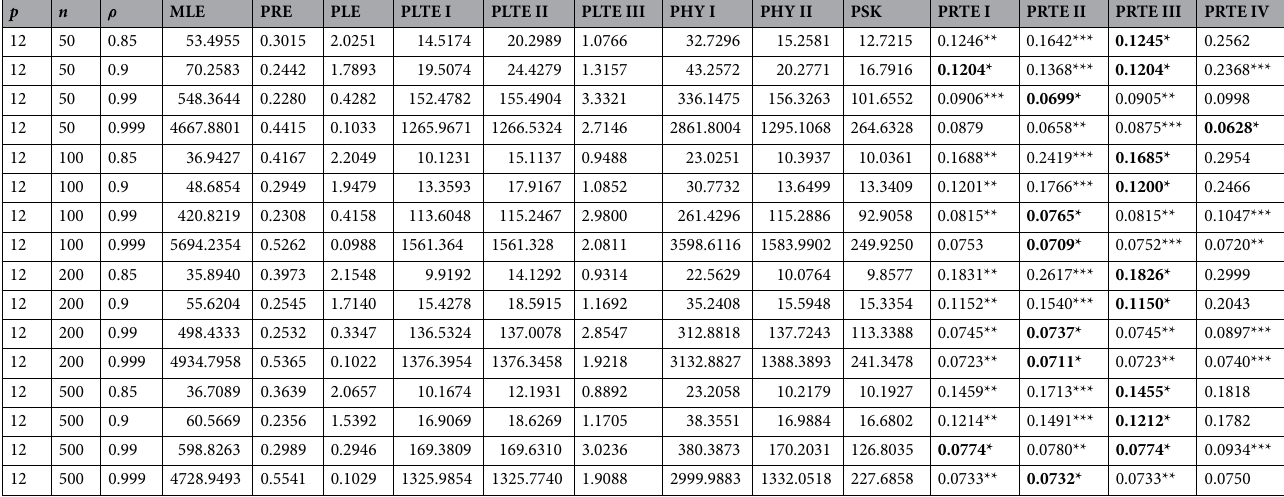
Table 4. The EMSE values of the estimators when p =